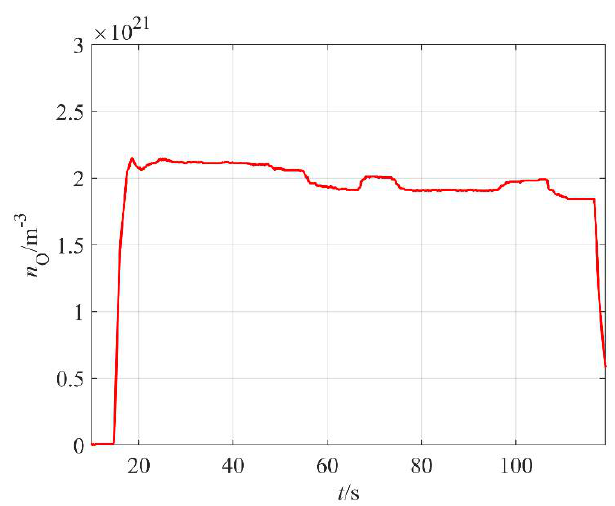
Figure 5. The behavior of O-atom density versus time ( t ) at 80 Pa and duty cycle 70%.